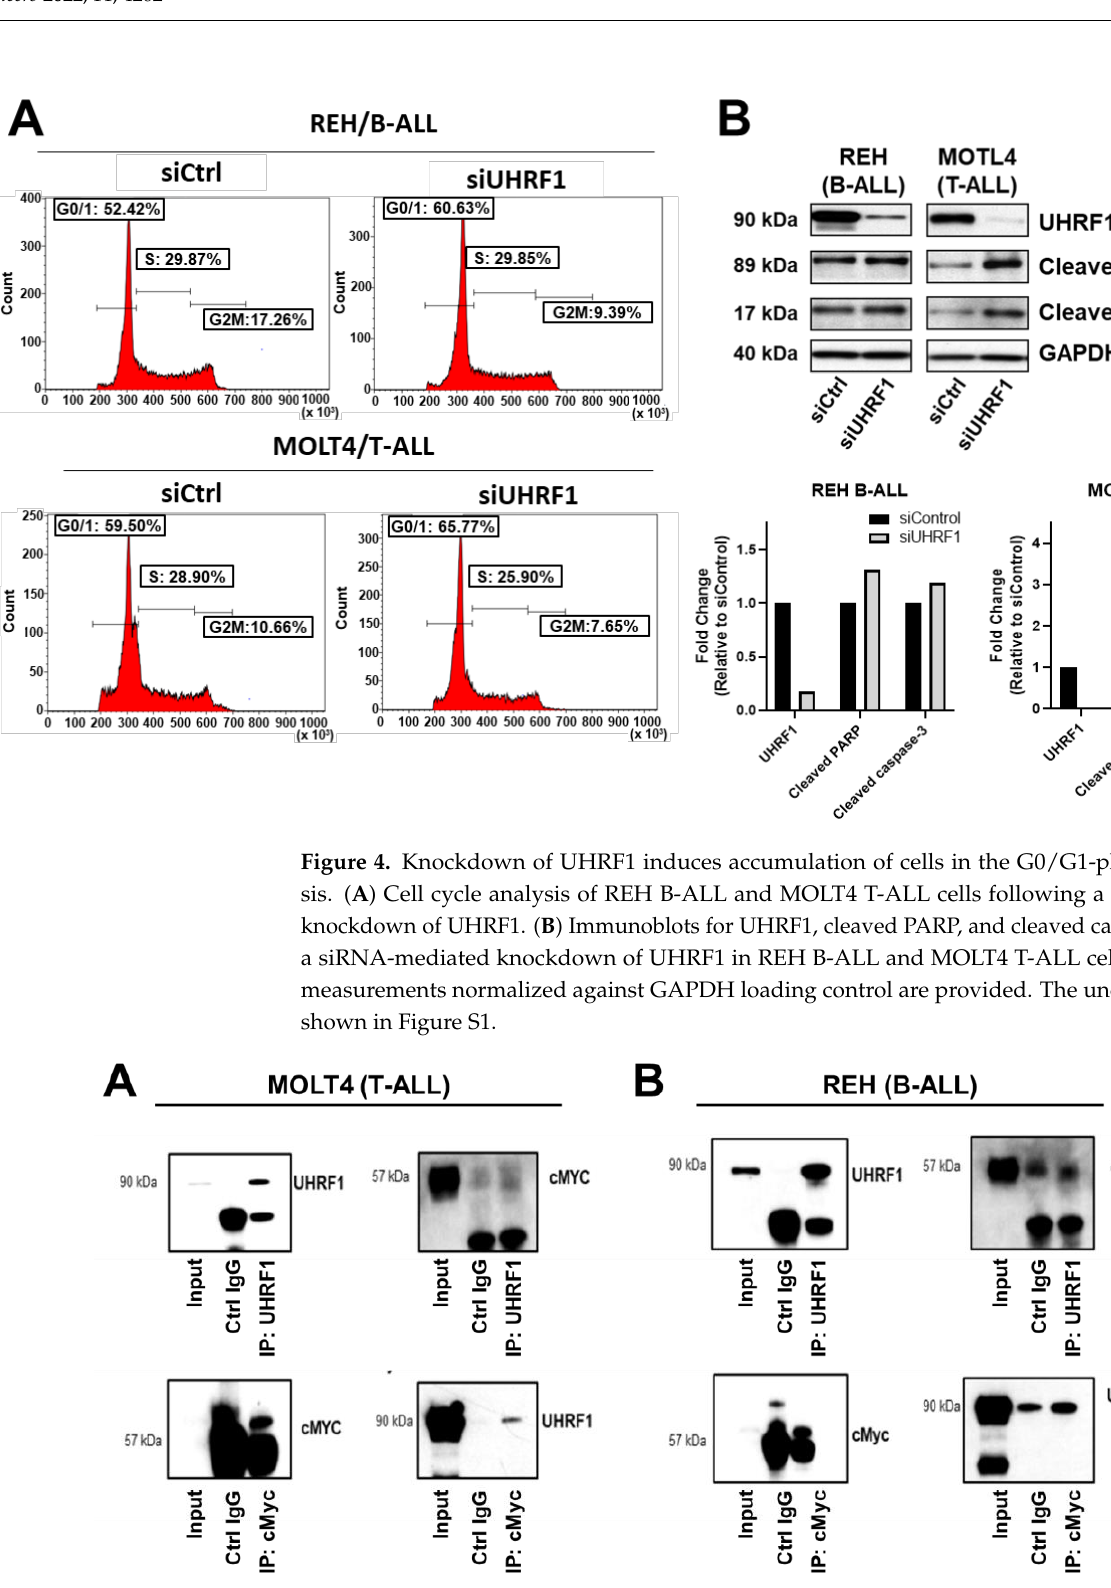
Figure 5. UHRF1 directly interacts with c-Myc. Co-immunoprecipitation/mass spectrometry was performed to determine the interaction between UHRF1 and c-MYC in ( A ) MOLT4 (T-ALL) and ( B ) REH (B-ALL). Lysates from MOLT4 and REH cells were subjected to co-immunoprecipitation with anti-UHRF1 and anti-c-Myc antibodies. The UHRF1 and c-Myc interacted with each other at endogenous protein levels. The uncropped blots are shown in Figure S1.